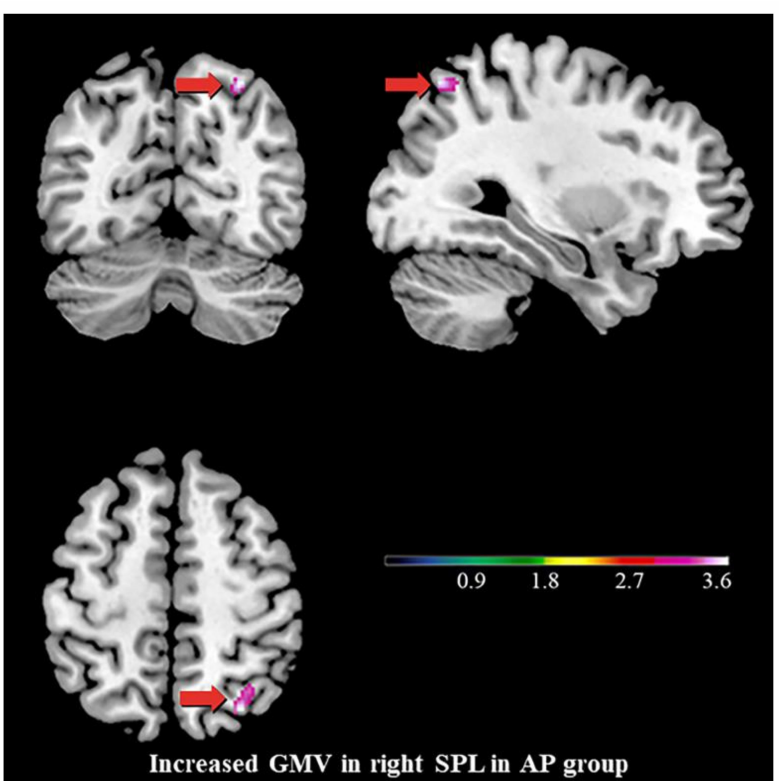
Figure 2. Significant difference in GMV between the AP and OP groups. This cluster contained 74 voxels, mainly in the right SPL, with a peak T value of 3.892. Significant at voxel p < 0.001, cluster p < 0.05, corrected by the GRF. The red arrow shows the corresponding brain region.